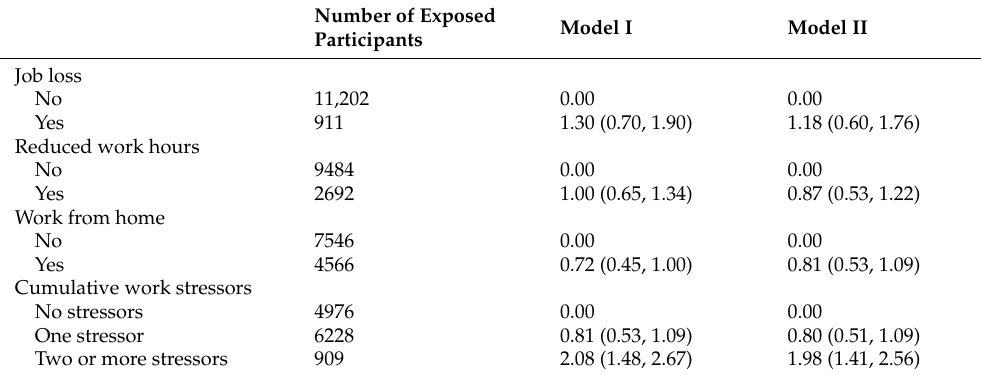
Table 2. Associations of Work Stressors with Psychological Distress ( β s and 95% CIs) ( N = 12,113). Number of Exposed Model I Model II Participants Job loss No 11,202 0.00 0.00 Yes 911 1.30 (0.70,